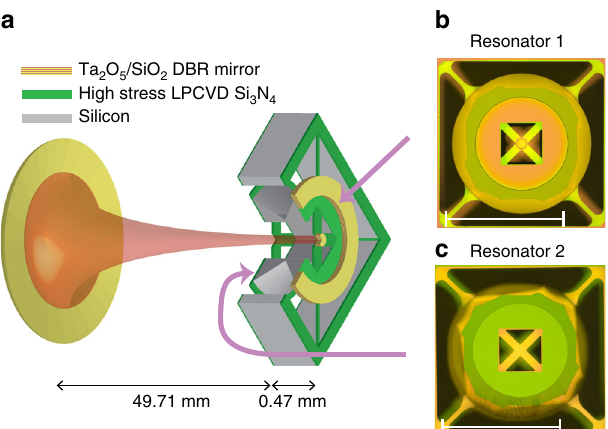
Fig. 1 Optomechanical set-up with two resonators in an optical cavity. a A schematic diagram of the optical cavity with two mechanical trampoline resonators. The resonators are constructed from low pressure chemical vapor deposition (LPCVD) silicon nitride. One resonator has a distributed Bragg re fl ector (DBR) mirror b and one resonator is a bare membrane c . b and c are optical microscope images of the two resonators, with 1 mm scale bar. The resonators are suspended from a shared outer resonator to provide mechanical isolation from the environment. This fi gure is not